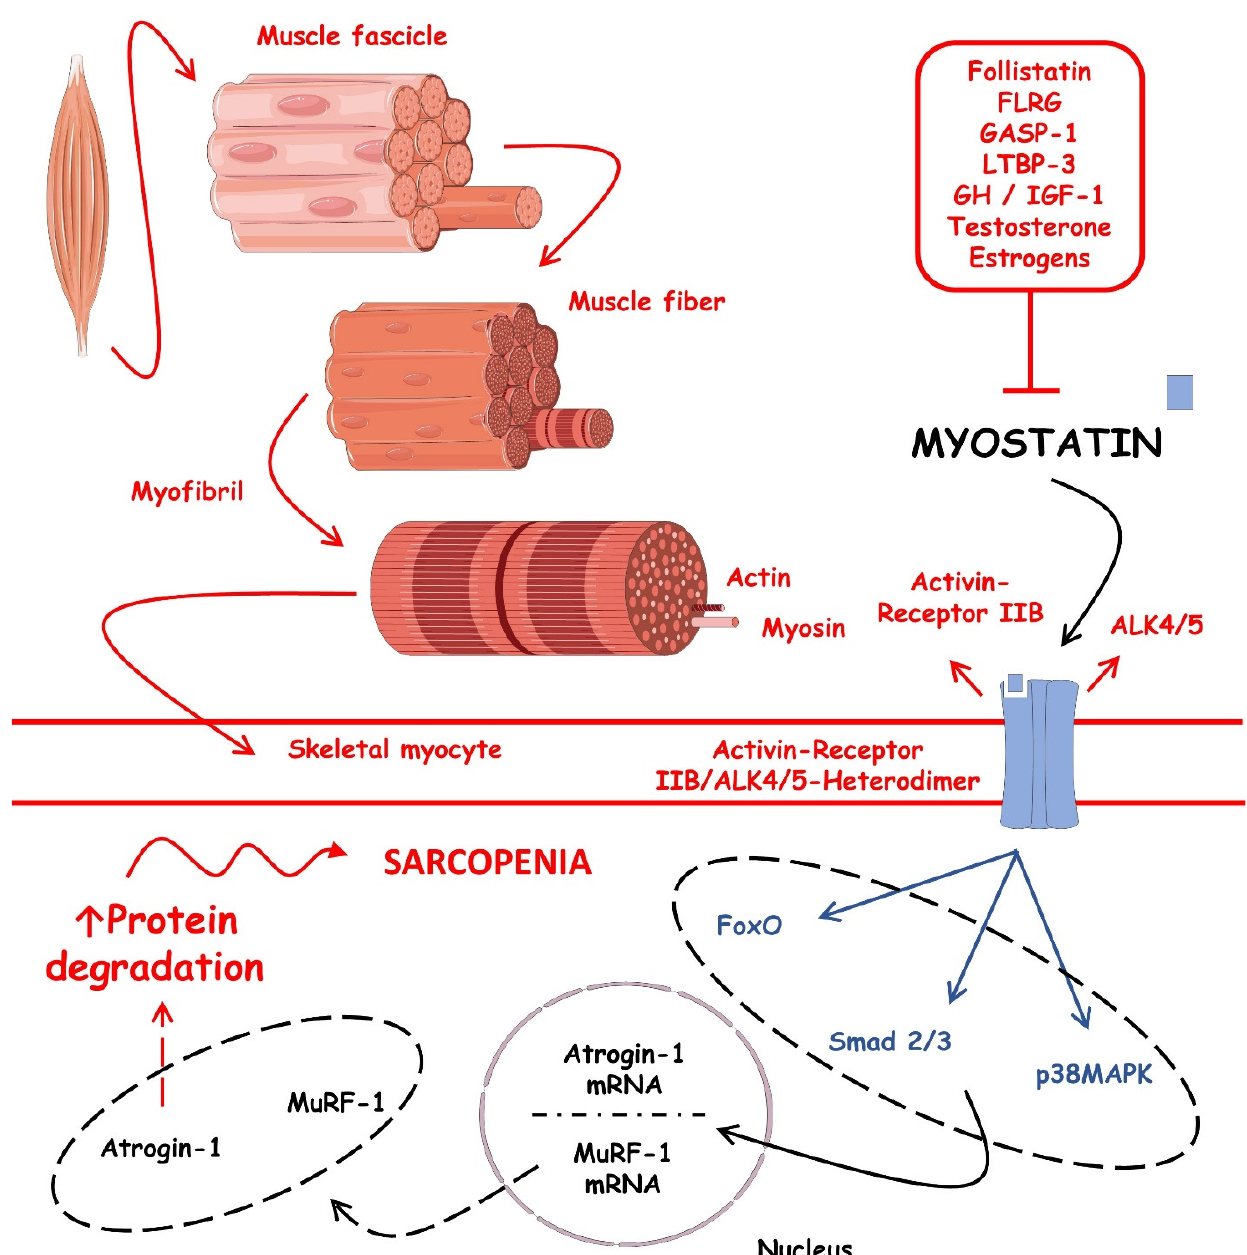
Figure 4. Intracellular signaling pathways involved in the myostatin regulation of protein degradation during sarcopenia. ↑ , increase; ALK4/5, anaplastic lymphoma kinase 4/5; FoxO, forkhead box O proteins; FLRG, follistatin-related gene-derived molecule; GASP-1, G-protein coupled receptor- associated sorting protein; GH, growth hormone; IGF-1, insulin-like growth factor 1; IIB, HAD- superfamily hydrolase; mRNA, messenger RNA; MuRF-1, muscle ring-finger protein-1; LTBP-3, latent-transforming growth factor beta-binding protein 3.